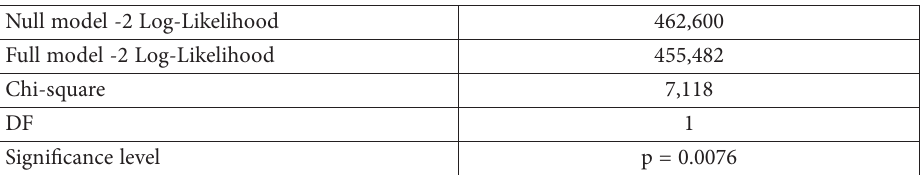
Table 1. The overall fit of the Cox proportional hazards regression model (source: own elaboration) Null model -2